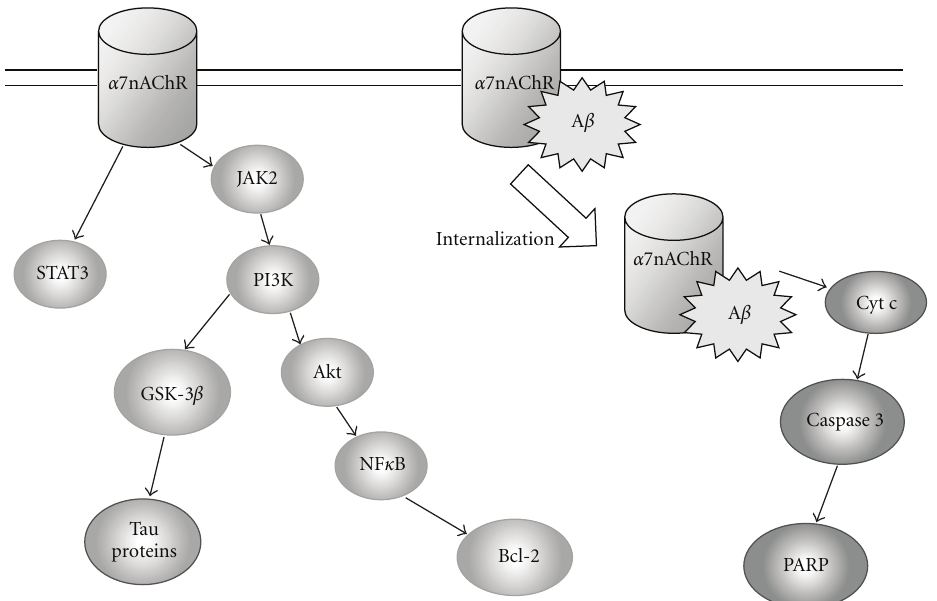
Figure 6: Schematic representation of neuroprotective role of α 7 nAChR.